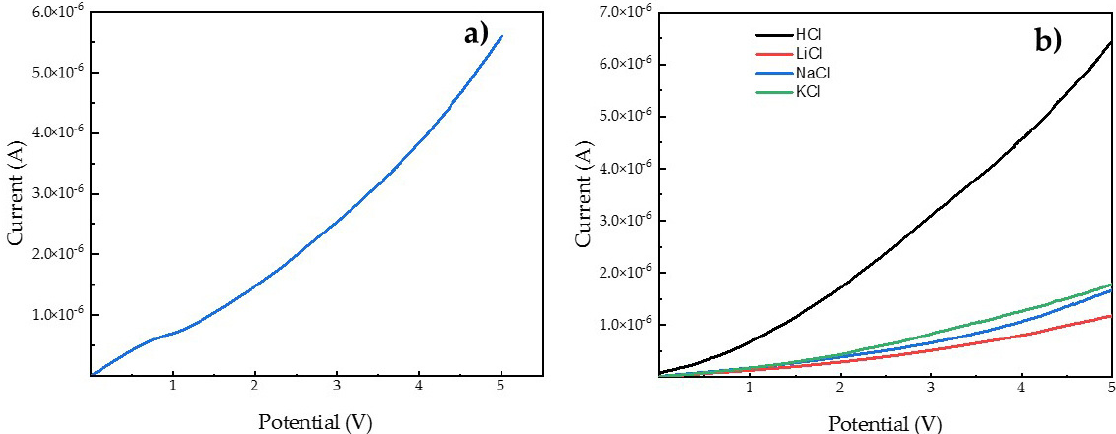
Figure 5. Linear sweep voltammetry curve of CP40 and 0.1M NaCl as electrolyte ( a ) and example of curves for different monovalent cations for CP20 ( b ).